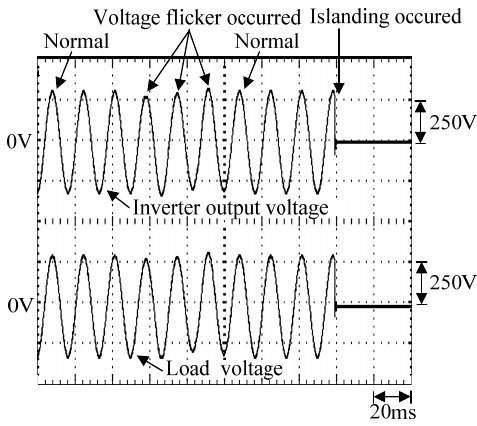
Figure 13. Diagram of islanding detection (voltage flickering before utility grid